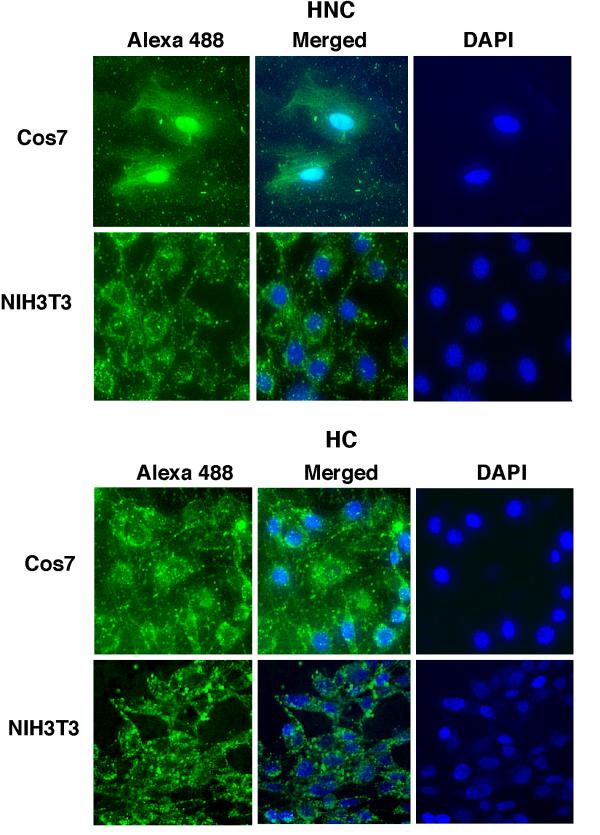
Intracellular localization of fluorescent Cre fusion proteins. Alexa 488-labeled HNC or HC proteins (1 μM) were incubated with Cos7 or NIH3T3 cells for 1.5 hr, and the living cells were directly visualized by fluorescence microscopy (green fluorescence, left panels). Cell nuclei counter stained with DAPI (blue fluorescence) are shown in the right panels and the merged images are shown in the middle panels.